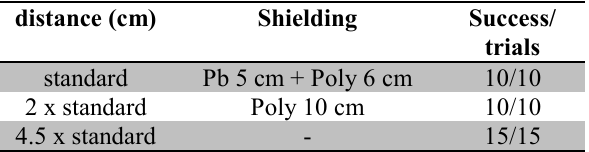
Fig. (cid:25). Pulse Shape Discrimination Plot obtained by a CAEN desktop digitizer with a NaIL™ 2”x2” coupled to a standard PMT. The thermal neutron region is the spot around 3000 keV. PSD = 1- (short gate integration/ long gate integration). For this detector the neutron region is below the gamma region because the Lithium dopant make the gamma signal slower